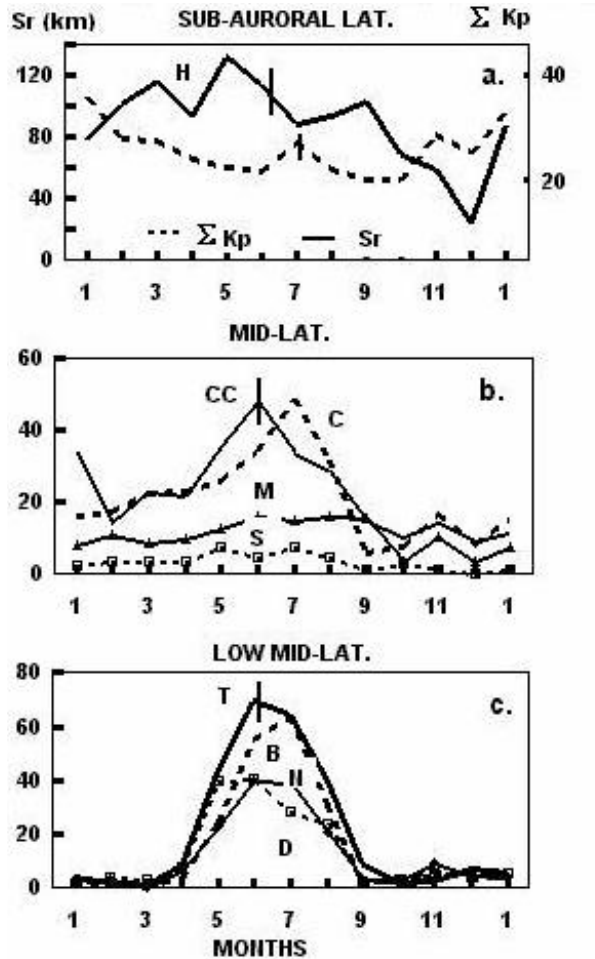
Fig. 3. Monthly (January 2004–January 2005) variations in the av- erage magnitude of range spread-F in the different regions of the midlatitude ionosphere. A typical standard error (the vertical bar) is shown as an